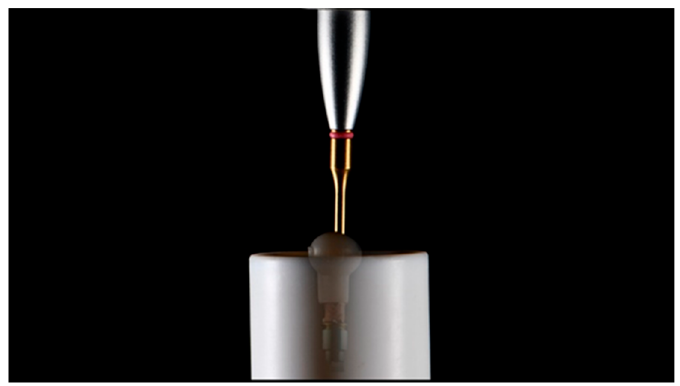
Figure 3. Customized tool used to remove the zirconia restorations.